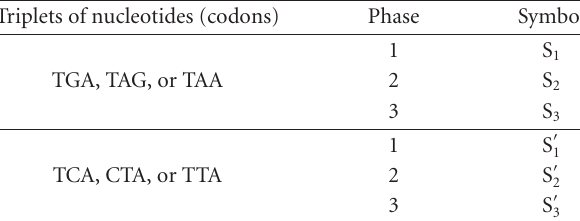
Table 3: Stop-codon mapping for 18-symbol alphabet. Triplets of nucleotides